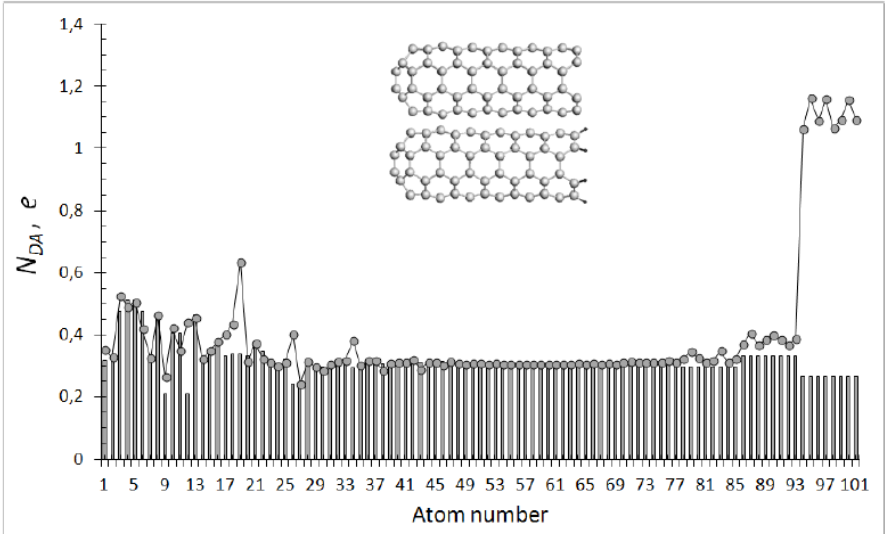
Figure 3. Standard ACS N DA image maps over atoms of (4, 4) single-walled carbon nanotubes shown in insert with empty (curve with dots) and hydrogen-terminated (histogram) ends. The numbering follows a movement along the tube atoms from the cap to the open end.